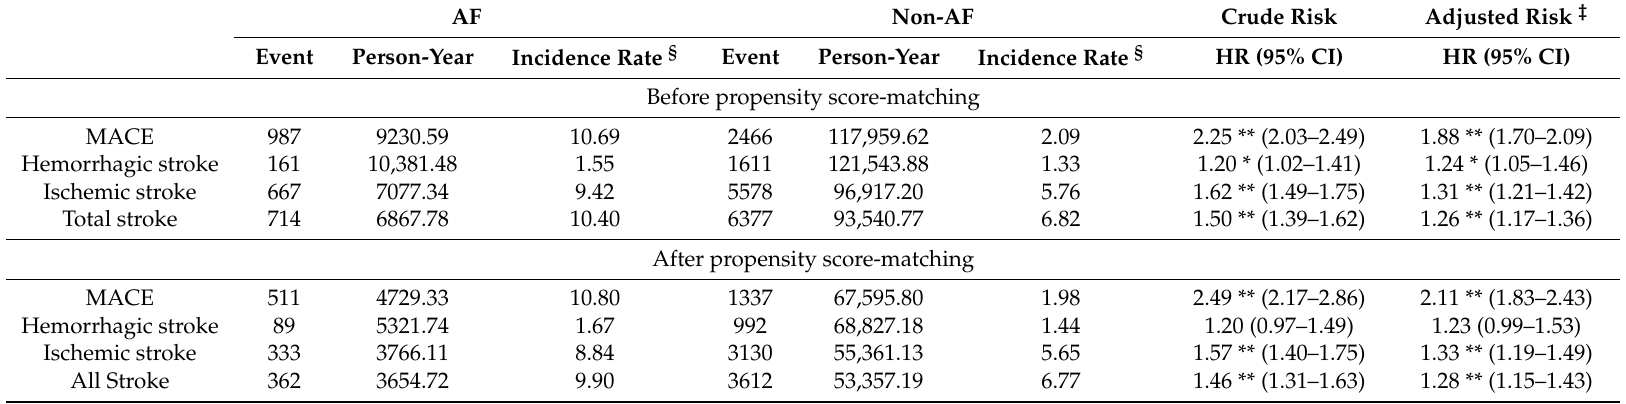
Table 4. Incidences and risks of major adverse events between patients with and without atrial